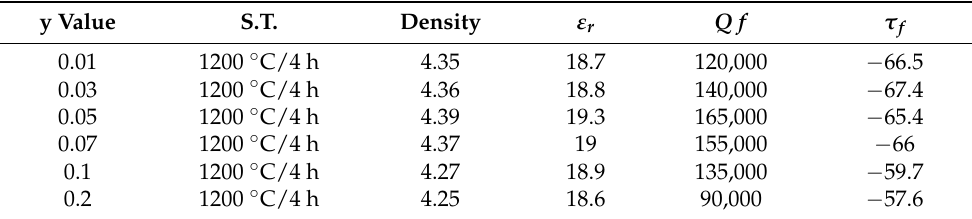
Figure 7. τ f value V.S sintering temperature of (Mg 0.6 Zn 0.4 ) 1 − y Ni y TiO 3 with y = 0.01–0.2. Table 2. Microwave dielectric performance of (Mg 0.6 Zn 0.4 ) 1 − y Ni y TiO 3 with various y values sintered at their optimized temperature for 4 h.